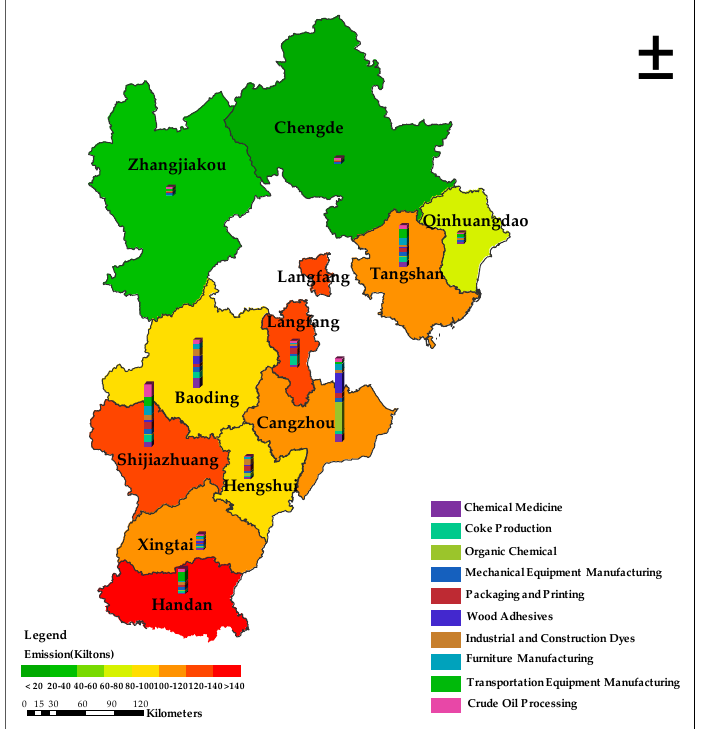
Figure 5. Spatial distribution of VOC emissions from industrial sources and key industries in Hebei Province for 2015. 144